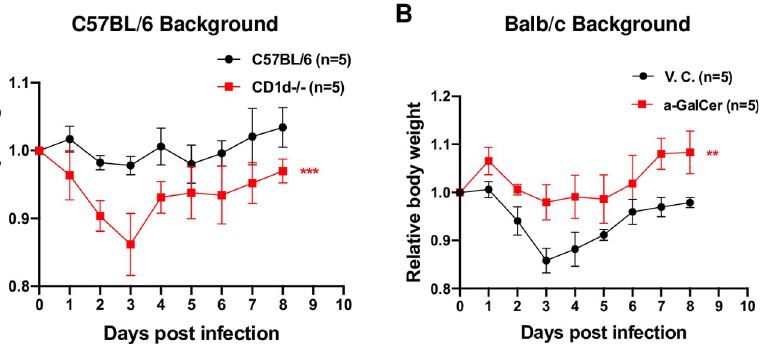
Fig 11. NKT cells are essential for optimal anti-SARS-CoV-2 immune responses and activation of iNKT cells can mitigate diseases caused by SARS-CoV-2 infection. (A). C57BL/6 or mCD1d-knockout (CD1d-/-) mice (n = 5 per group) were infected with mouse-adapted virus CMAp20 strain (1X10e6 pfu/mouse). (B). Balb/c mice (n = 5 per group) were infected with CMAp20 strain (1X10e6 pfu/mouse) then treated with vehicle control (v.c.) or α -GalCer (2 μ g/mouse). Mouse body weight was monitored daily. Statistical analyses were performed using two-way ANOVA followed by Sidak’s post-test. ** p < 0.01; *** p < 0.001.